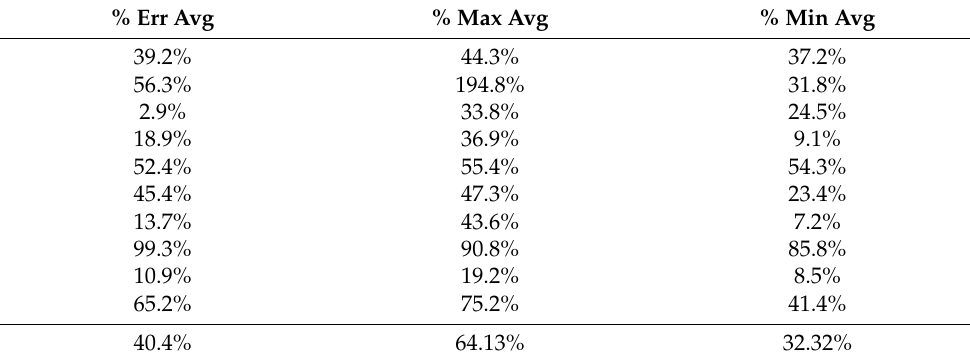
Table A55. Set 1, trials 31–40 data (single 0.5 PR value).